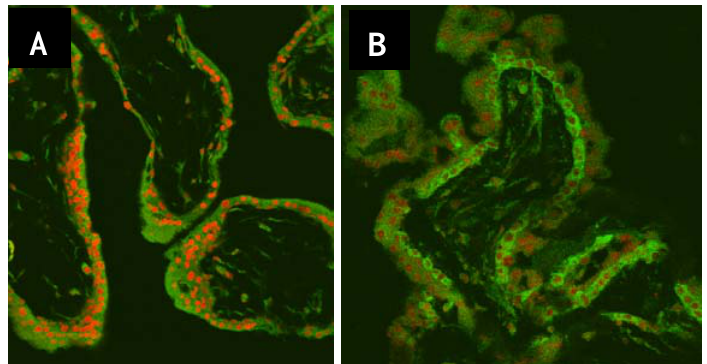
Figure 3. Immunofluorescence in the unclei and nuclear translocation with NF- κ B protein p65 in villi. (A), Control; (B), Early spontaneous miscarriage. CLSM × 200 (Green color indicates positive staining for NF- κ B protein p65; Red color indicates